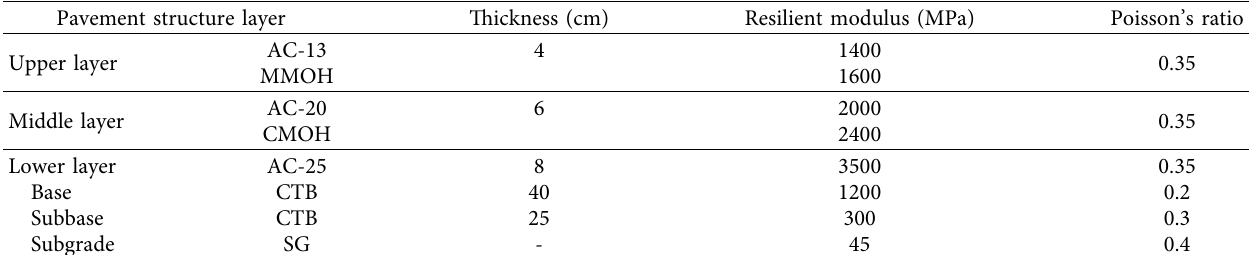
Table 1: Pavement structure materials and parameters.